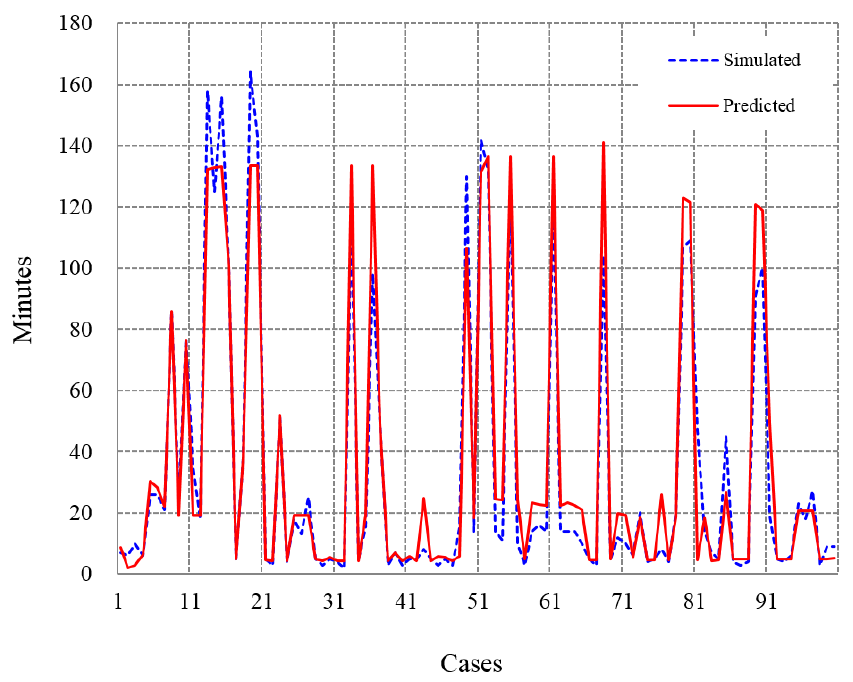
Figure 16. Comparison of the simulation and prediction